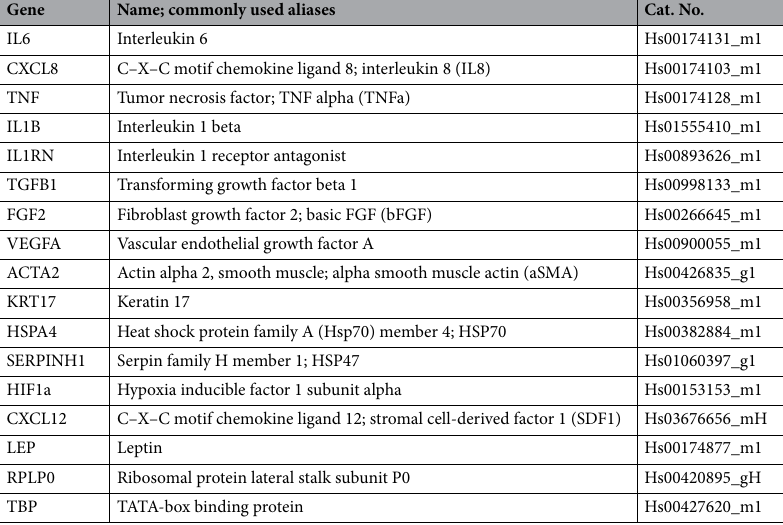
(line) the interquartile range (box) and the minimum and maximum values (whiskers) from at least three inde- pendent experiments. Numbers of individual skin explants (n) are indicated for specific results in the respective figure legends. Due to limited sample amounts, not all genes were analyzed for all experiments. Samples were excluded from further analysis when at least one of the two endogenous control genes failed to give a Cq value. Cytokine analysis. Human skin biopsies were homogenized in 500–1000 µl buffer (50 mM Tris HCl pH 7.6 supplemented with 1:100 Protease Inhibitor Single Use Cocktail and 1:100 Phosphatase Inhibitor Cocktail; both Thermo Fisher Scientific, MA, USA) using the Bead Ruptor Elite device (Omni International, GA, USA) with two 30 s cycles (7.3 m/s). Samples were incubated on ice for 2 min between cycles and prior to centrifuga- tion (10 min, 10,000 g , 4 °C). Homogenates were aliquoted and stored at − 80 °C. Total protein concentration was determined using a bicinchoninic acid assay (Pierce BCA Protein Assay Kit, Thermo Fisher Scientific MA, USA). Briefly, 25 µl of homogenized sample were mixed with working reagent in a microplate for 30 s. The plate was incubated at 37 °C for 30 min and after cooling to room temperature, the absorbance was measured at 570 nm, protein concentrations were determined in comparison to a bovine serum albumin (BSA) derived standard curve. The V-PLEX Pro-inflammatory Panel 1 Human Kit (Meso Scale Diagnostics, MSD, MD, USA) was used to determine the concentrations of 10 cytokines in parallel (IFNG, IL1B, IL2, IL4, IL6, IL8, IL10, IL12p70, IL13, TNF) in the skin homogenates according to the manufacturer’s instructions. The plates were read on the MESO QuickPlexTM SQ 120 instrument (MSD, MD, USA). Cytokine concentrations (pg/ml) were normalized to protein input (µg). Results are presented as median